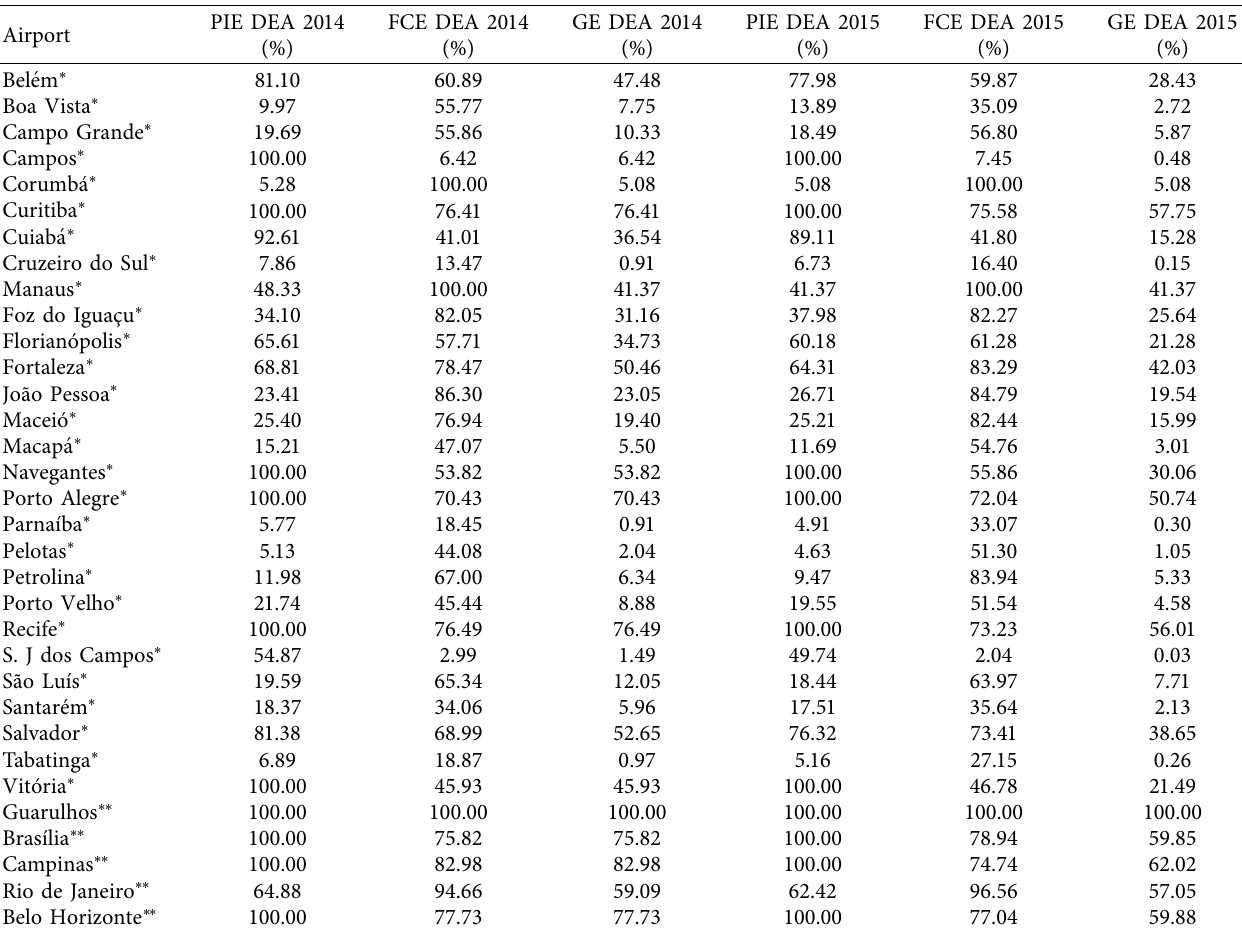
Table 1: Physical infrastructure, flight consolidation, and global efficiencies (2014 and 2015).